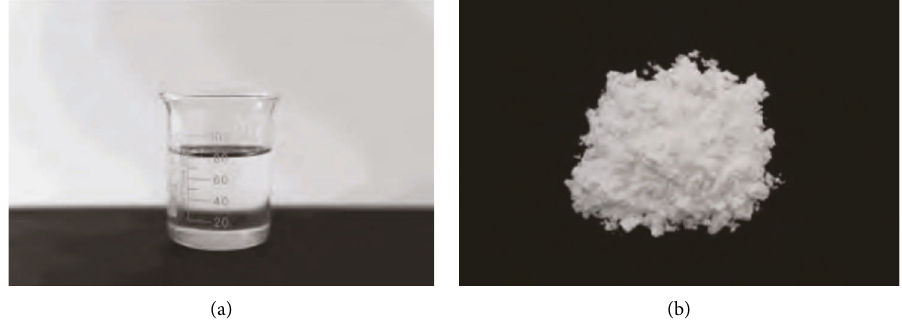
Figure 5: Phase change materials. (a) pPCM. (b) mPCM.